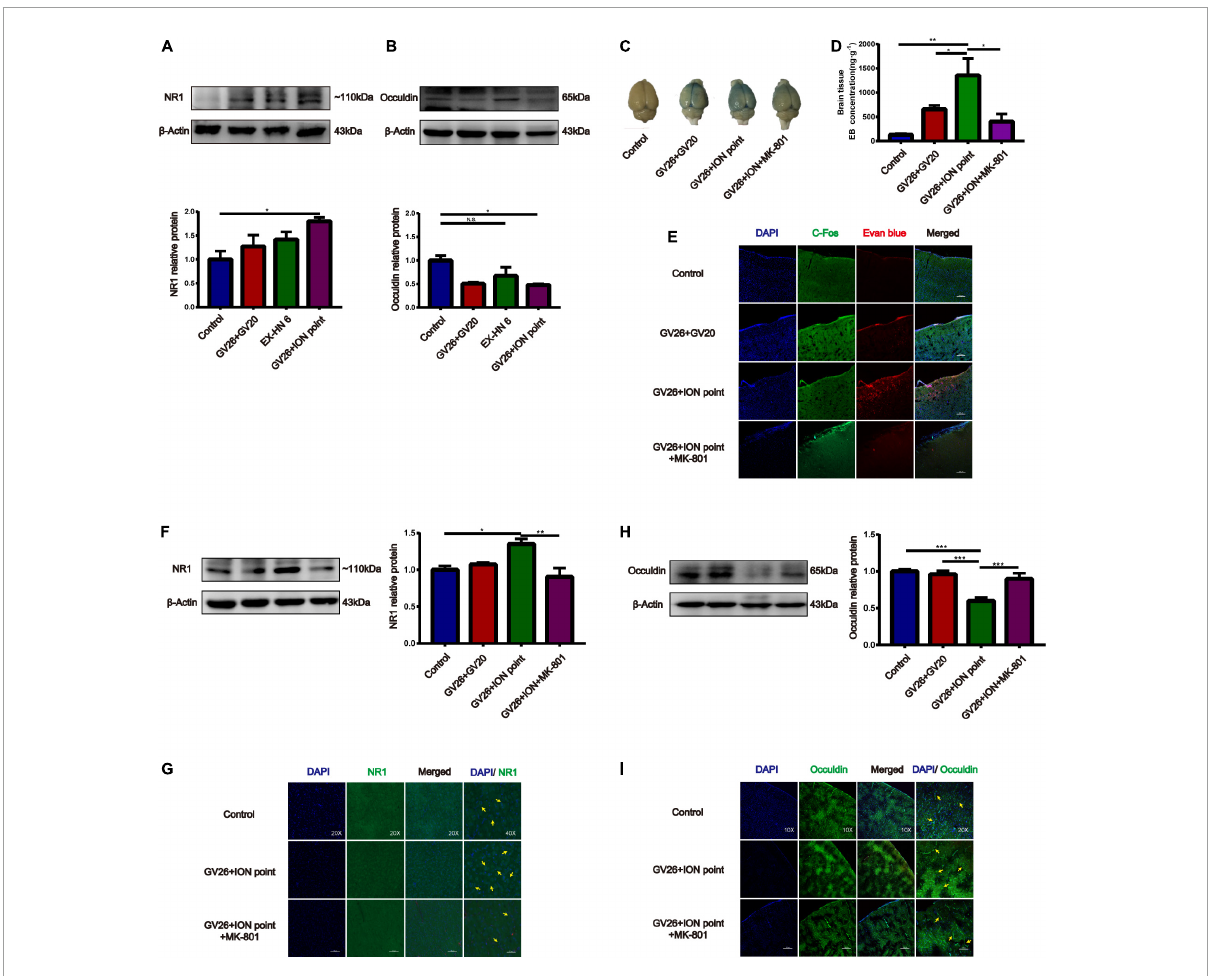
FIGURE4 The role of NMDA receptors in EA stimulation of the trigeminal nerve to promote BBB opening and the effect on TJ occludin. (A) NR1 protein expression induced by EA at different head acupoints; Compared to the control group, NR1 protein expression was increased in all the EA groups, but the increase was most significant in the GV26 + ION group, * P < 0.05, GV26 + ION point group vs. control group, n = 6/group. (B) Occludin protein expression induced by EA at different head acupoints; occludin protein expression was decreased in the GV20 + GV26 group and GV26 + ION group, * P < 0.05, GV26 + ION point group vs. control group, P > 0.05, control group vs. EX-HN6 group, n = 6/group. (C) Shows the degree of brain EB penetration of each group under naked eye observation. (D) When NMDA receptor blocker MK-801 was used before EA of the trigeminal nerve, EB concentration in the cerebral cortex was decreased; * P < 0.05, GV26 + ION point group vs. GV26 + ION point + MK-801 group, n = 6/group. (E) The cerebral cortex EB and c-Fos fluorescence expression of the different groups, EA GV26 + ION group cerebral cortex EB and c-Fos. (F) EA GV26 + ION group NR1 protein expression was significantly decreased after using MK-801, ** P < 0.01, GV26 + ION point group vs. GV26 + ION point + MK-801 group, n = 6/group. (G) EA GV26 + ION group cerebral cortex NR1 fluorescence expression(green, surrounding neuronal cytosol) was significantly decreased after treatment with MK-801 (yellow arrows). (H) EA GV26 + ION group occludin protein expression was significantly increased after treatment with MK-801, *** P < 0.001, GV26 + ION point